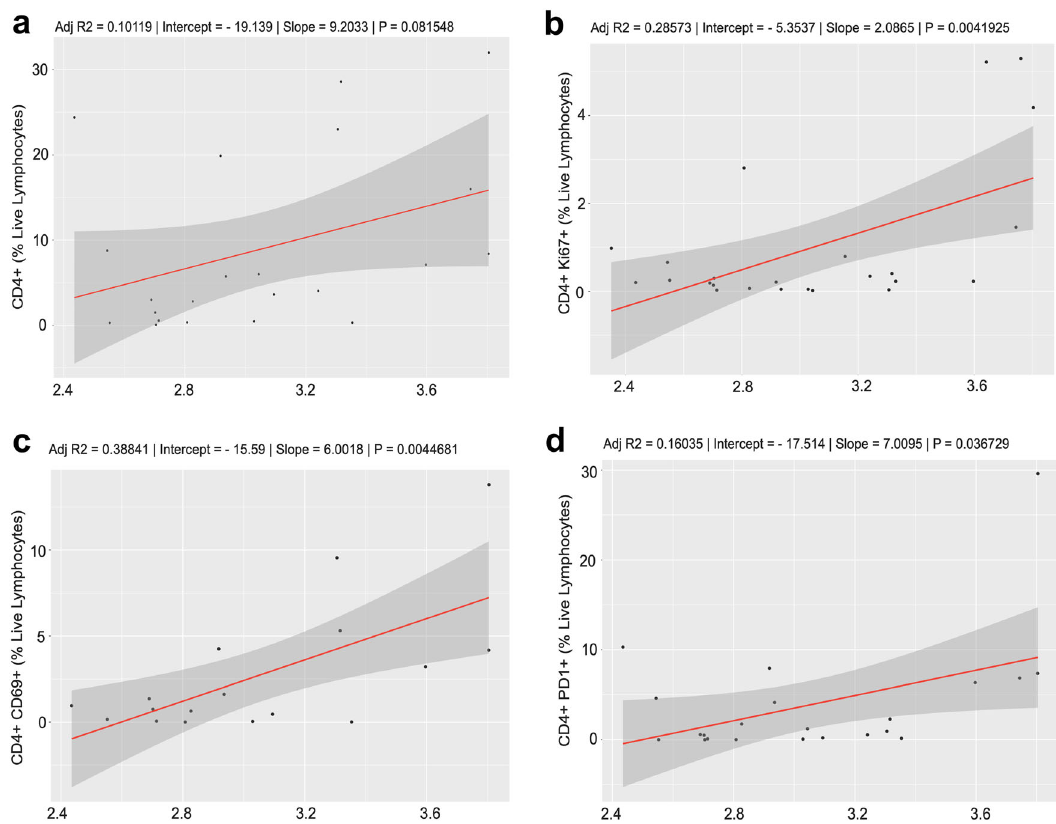
Fig. 3 Correlation analysis of Shannon Diversity Index with tumor immune signatures. a – d Spearman correlations between Shannon Diversity Index and CD4 + , CD4 + Ki67 + , CD4 + CD69 + , and CD4 + PD1 + . Statistical analysis was performed by Spearman correlation or Mann – Whitney